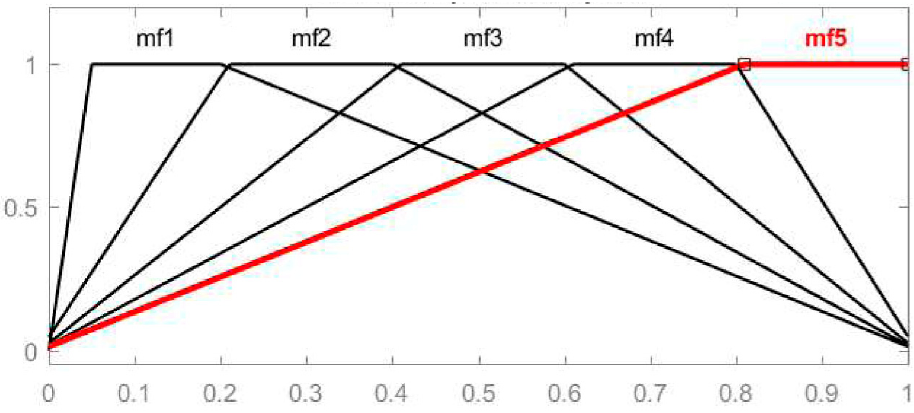
Figure 3. LEE membership functions in the Mamdani model.